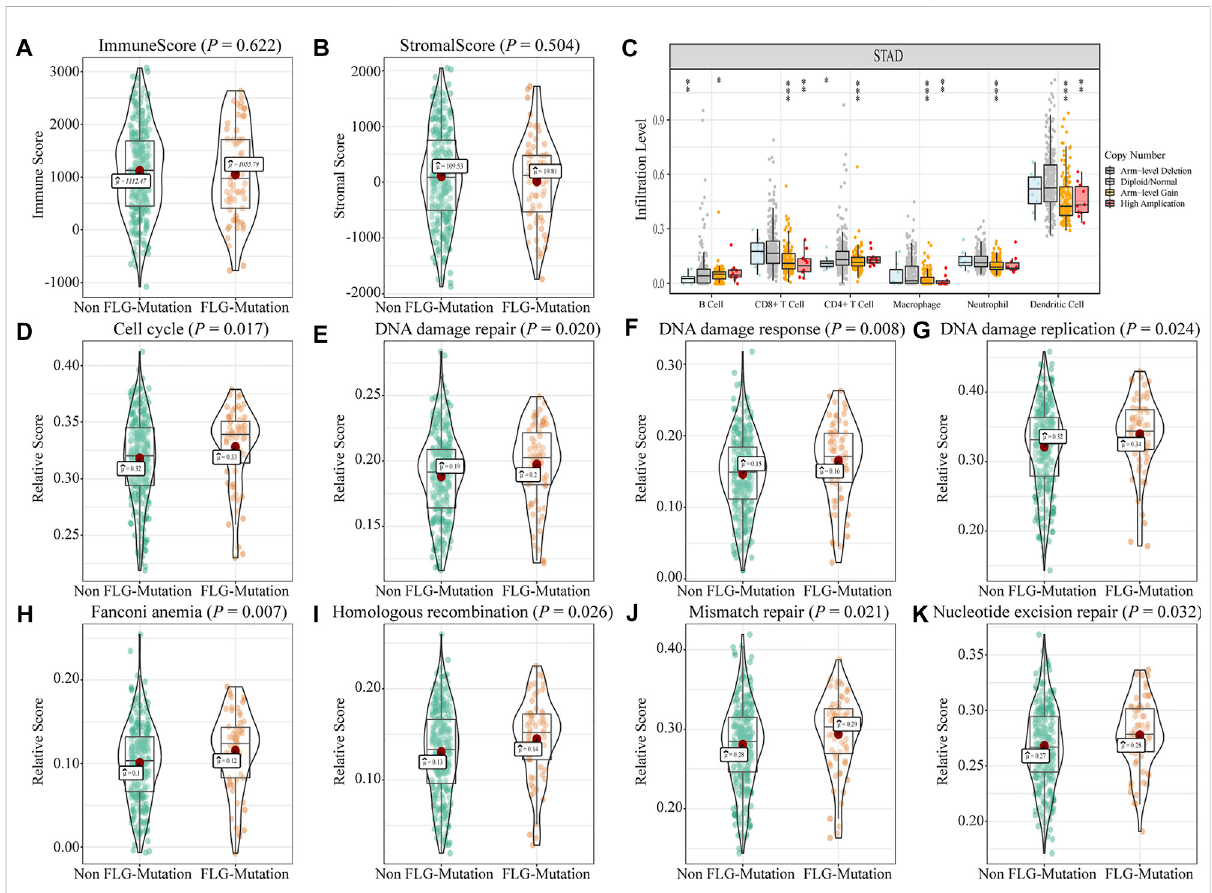
FIGURE 3 Effectsof FLG genemutationsonimmunologicalcharacteristicsinTCGA-STADdatasets. (A) InTCGA-STADdatasets,theimmunescoresinthe FLG -mutant group were unremarkable compared to those in the non-mutant group. ( p = 0.622). (B) Matrix score in the FLG -mutant group was unremarkable compared to that in the non-mutant group. ( p = 0.504). (C) Immune cell in fi ltration was analyzed using the TIMER website. The signi fi cant differences were observed in the immune cell in fi ltration between FLG -mutant and non-mutant groups. (D – K) Biological functions weresigni fi cantlydifferentbetweenmutantandnon-mutantgroups( p < 0.05),includingcellcycle – relatedpathways,DNAinjuryrepairment-related